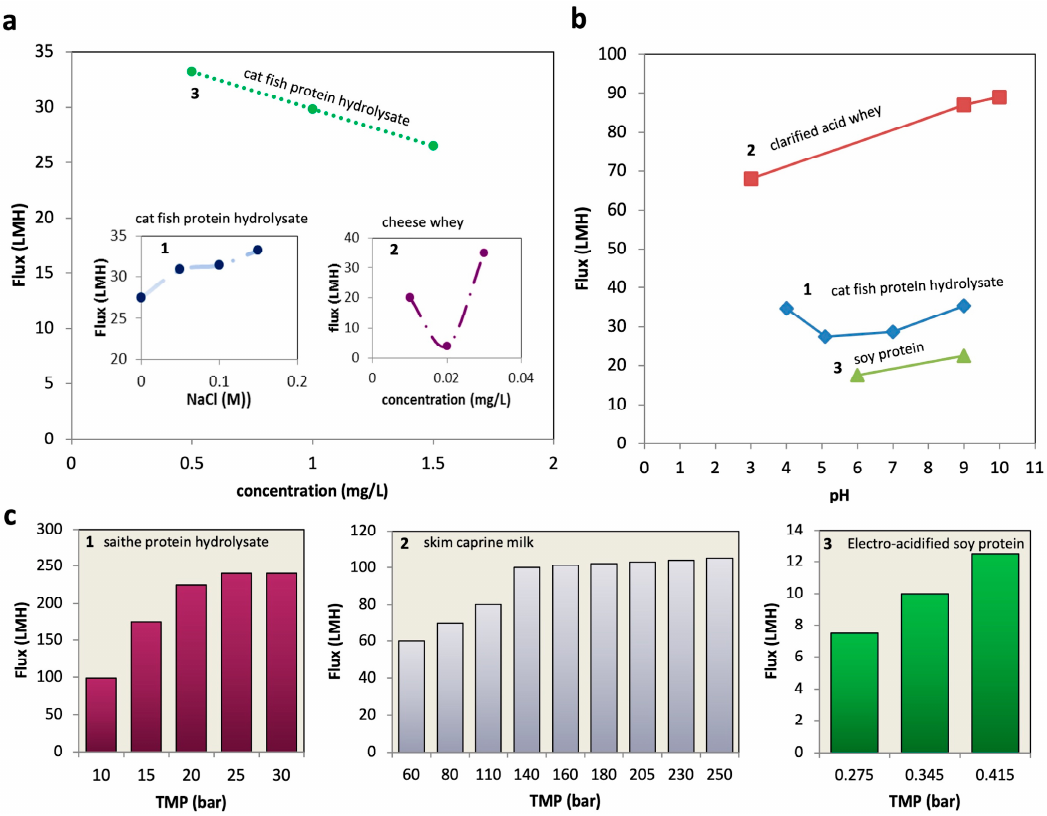
Figure 7. The effects of various parameters on UF flux ( a ) protein concentration and ionic strength; ( b ) pH; ( c ) TMP. Membranes in a1, a3: RC 5 kDa [197], a2: PS 30 kDa [198], b1: RC 5 kDa [197], b2: ceramic membrane ZrO 2 -TiO 2 (0.045 m 2 ) [177], b3: PS hollow fiber 100 kDa (this data) after EDBM with Electrocell AB (eff electrode area 100 cm 2 ) [199], c1: tubular PES 4 kDa [194], c2: tubular ceramic 4 kDa [200], c3: hollow fiber PS 100 kDa [201].